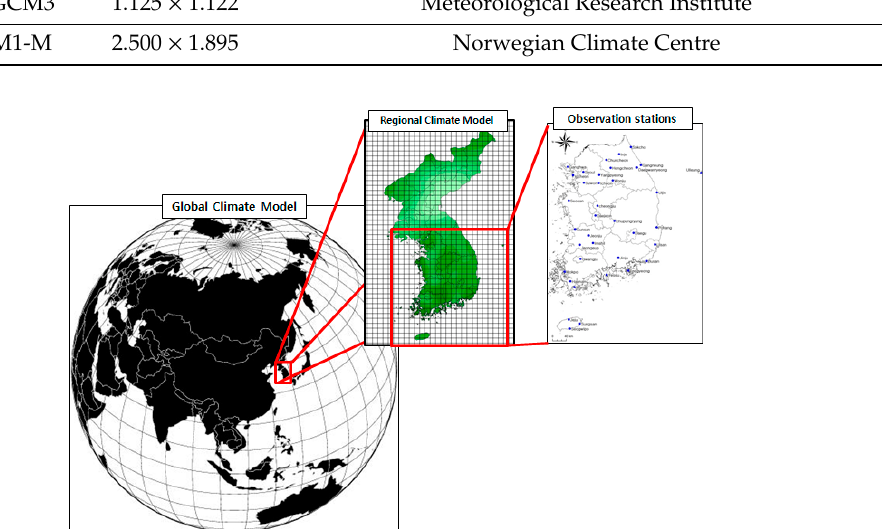
Figure 4. Climate Change Scenarios Used in This Study.